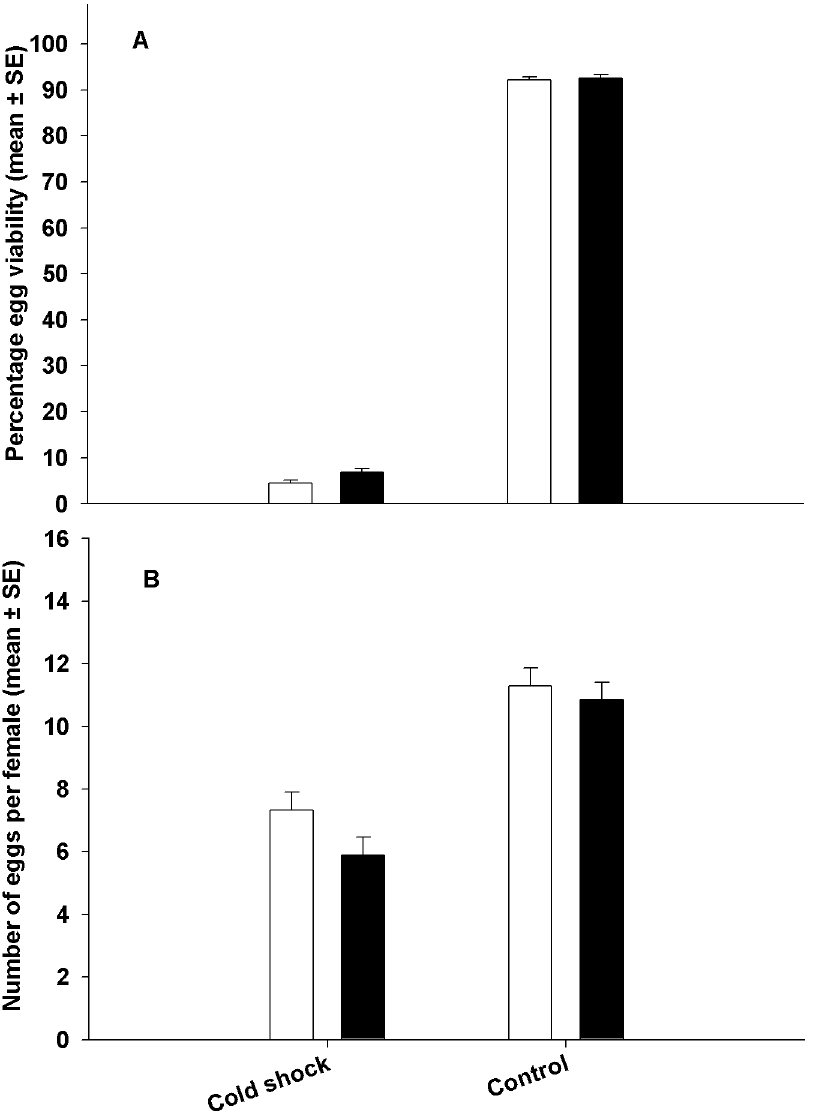
Fig 4. Effect of cold shock on egg viability and fecundity. To quantify egg viability (A) and fecundity (B) Females were held without access to males post cold shock. In this experiment, females were allowed to interact with males initially. However, after cold shock (or control treatment), females were not allowed to interact with males. We then assayed their egg viability (A) and fecundity (B) 24 hours later. Egg viability and fecundity of females subjected to cold shock and not allowed to interact with males thereafter was significantly lower. We found no significant differences in egg viability or fecundity between FCB (open bars) and FSB (closed bars) in either of the treatments. These results are in contrast to the results presented in Figs 1 and 2 wherein females had access to males post cold shock. Thus, taken together, these results indicate that interaction with males post cold shock is necessary for egg viability and fecundity to